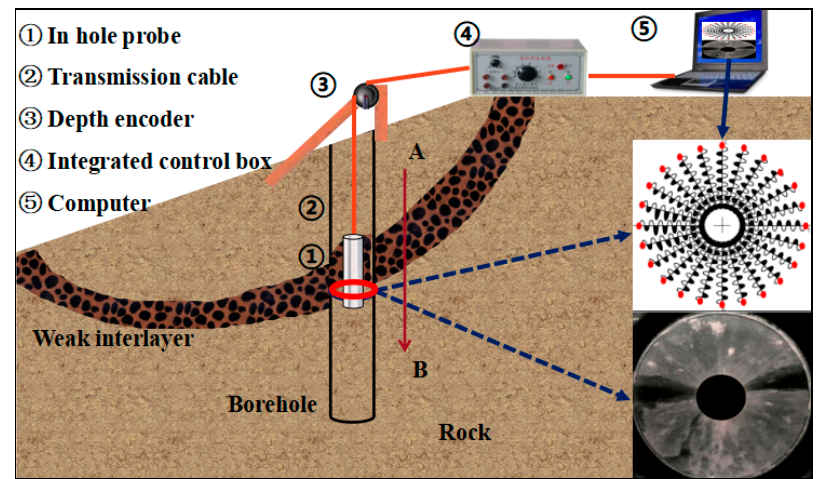
Figure 1. Schematic diagram of working principle.